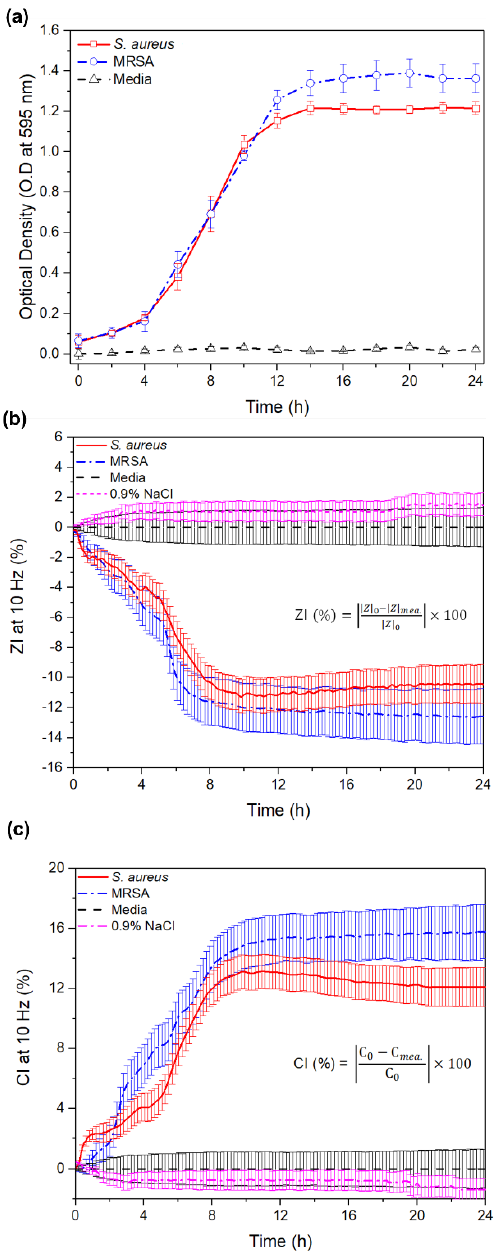
Figure 5. Typical bacterial growth curve measured over a period of 24 h at 595 nm (optical density (OD) = λ 595nm ) ( a ), and capacitance index (CI) and impedance magnitude index (ZI) for MRSA and S. aureus at 10 Hz ( b , c ) (standard error, n =